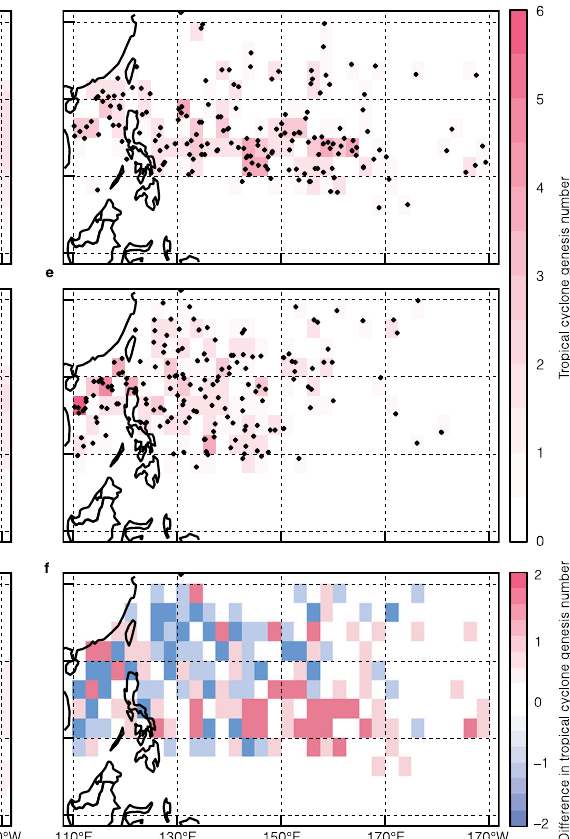
Fig. 2 | Tropical cyclone (TC) genesis numbers during El Niño and La Niña and theirdifferences.a TheTCgenesisnumbersestimatedusingthegenesispotential index(GPI ocean )duringElNiño, b isforLaNiña,and c isforthedifferencesbetween El Niño and La Niña. d – f are the same as a – c but from the Joint Typhoon Warning